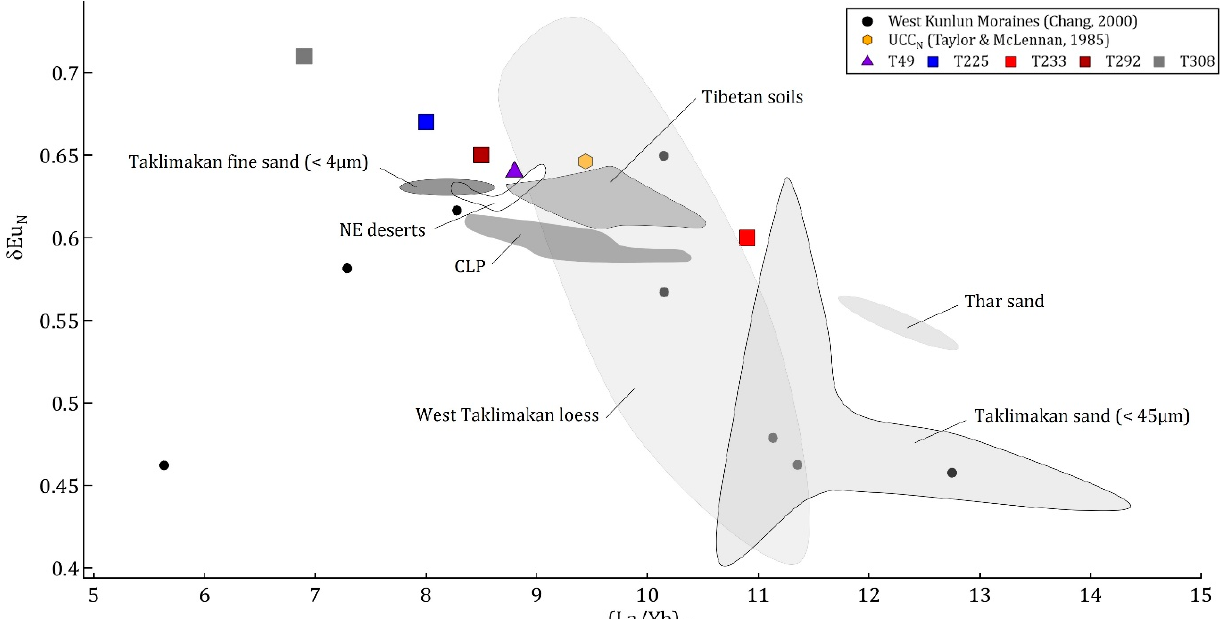
Figure 10. REE-based provenance signatures of Guliya dust filters compared to that of the Upper Continental Curst (UCC) [94] and the Central Asian deserts: Chinese Loess Plateau (CLP) loess; Taklimakan fine sand; Northeast deserts (Mu Us, Hobq, and Badain Jaran deserts); Tibetan soils, and Thar desert [76]; West Kunlun moraines [92]; and Taklimakan sand and West Taklimakan loess [36]. The N subscript in δ Eu N and (La/Yb) N indicates that values are normalized to the C1 chondrite